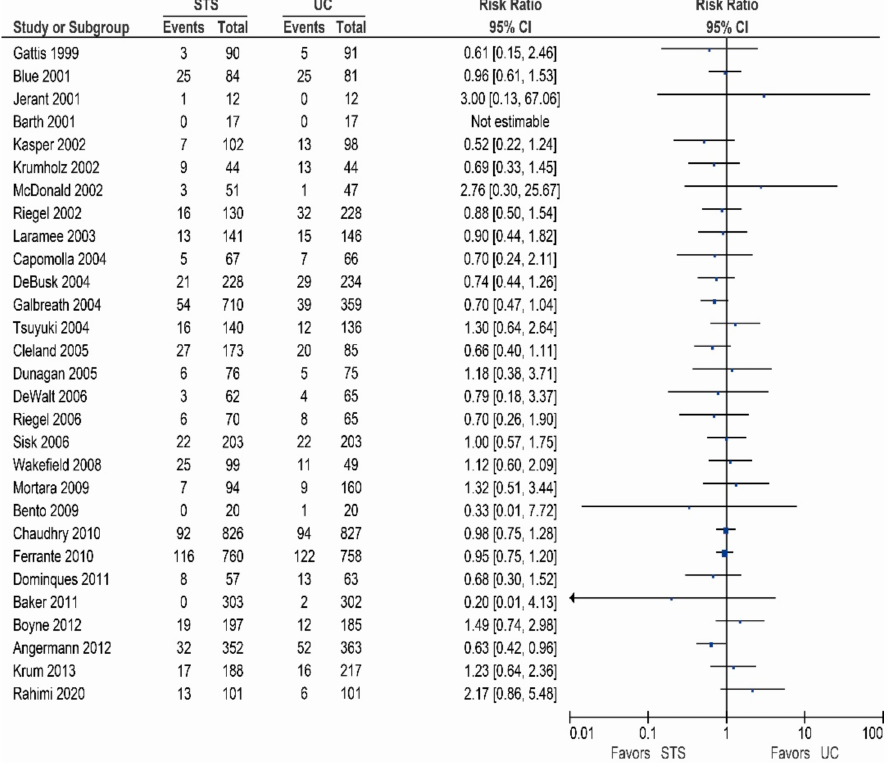
Figure 1. All-cause mortality in patients receiving structured telephone support versus usual